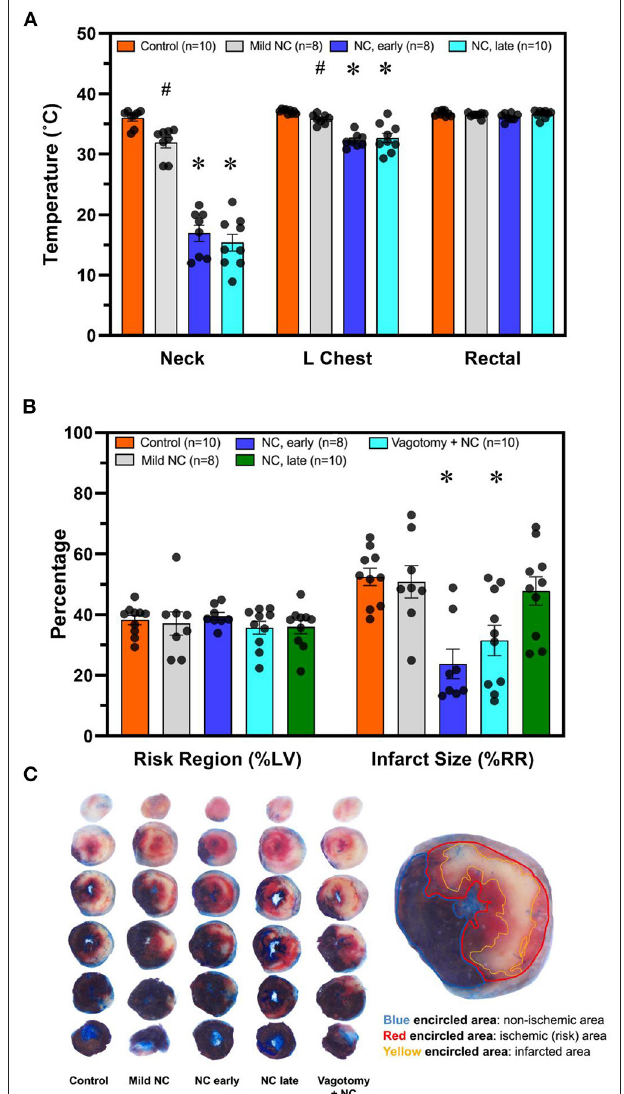
FIGURE 3 | NC without systemic hypothermia attenuates myocardial infarct size in a vagus nerve- and temperature-dependent manner, with earlier initiation resulting in superior infarct sparing effect. (A) Temperature was measured 10min after initiation of topical neck cooling interventions in the left pleural place and neck subcutaneous tissue. Core temperature was measured rectally. (B) Myocardial infarct size was calculated as a percentage of left ventricle area at risk after 40min of left coronary artery occlusion followed by 60min of reperfusion. Application of topical neck cooling interventions, as well as the effect of vagotomy at the gastroesophageal junction, was compared to normothermic control. (C) . Representative TTC-Blue staining left ventricle slices to determine RR and IS. Mild NC topical neck cooling with tubing containing room-temperature water; early NC topical neck cooling with ice-filled tubing initiated 5min after LCA occlusion ; late NC topical neck cooling with ice-filled tubing initiated 10min prior to reperfusion ; vagotomy + NC vagotomy at the gastro-esophageal junction prior to left coronary occlusion and initiation of topical neck cooling with ice-filled rubber-tubing 10min prior to reperfusion. LCA, left coronary artery; RR, risk region; LV, left ventricle; IS, infarct size. * p < 0.05 vs. control and mild NC; # p < 0.05 vs. control